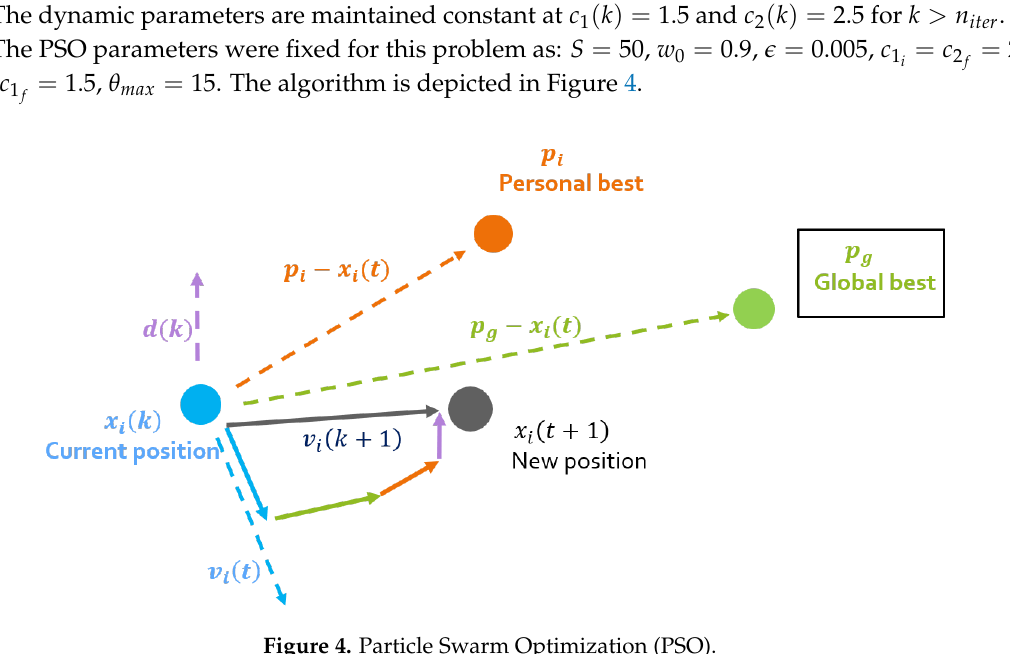
Figure 4. Particle Swarm Optimization